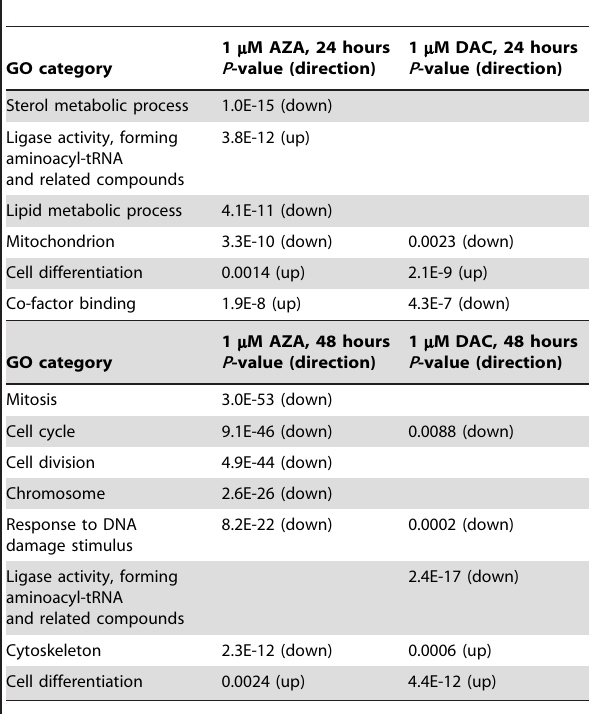
Table 3. Gene biogroups significantly regulated by AZA or DAC in KG-1a